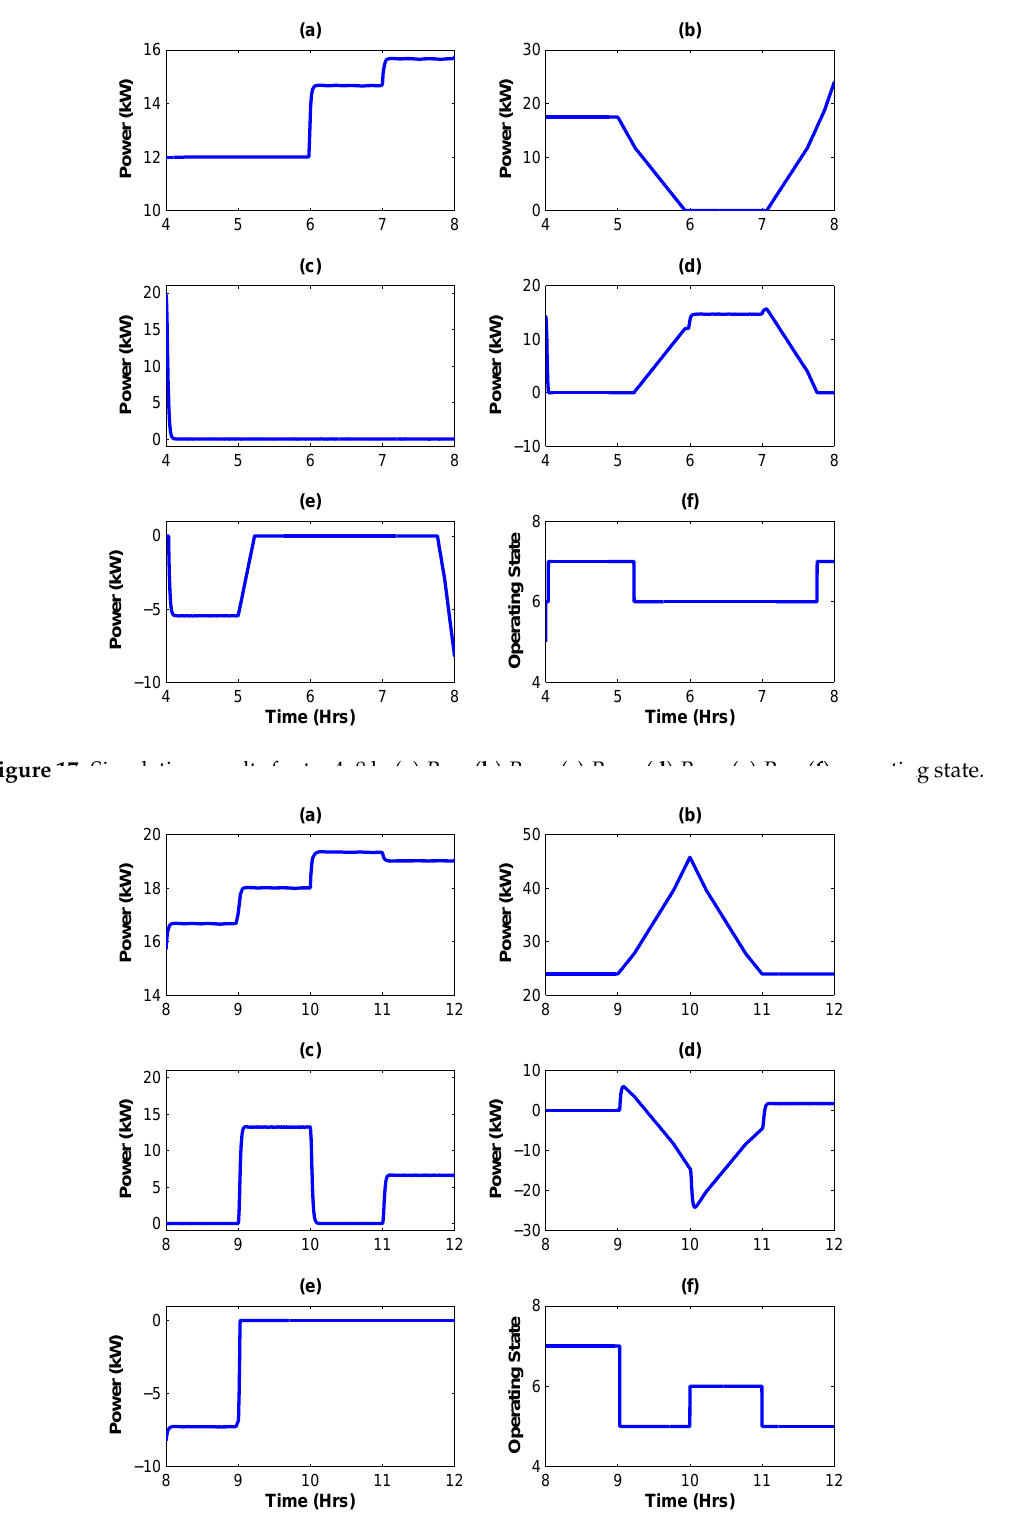
Figure 18. Simulation results for t = 8–12 h; ( a ) P DL , ( b ) P WT , ( c ) P CDi , ( d ) P NG , ( e ) P ES , ( f ) operating